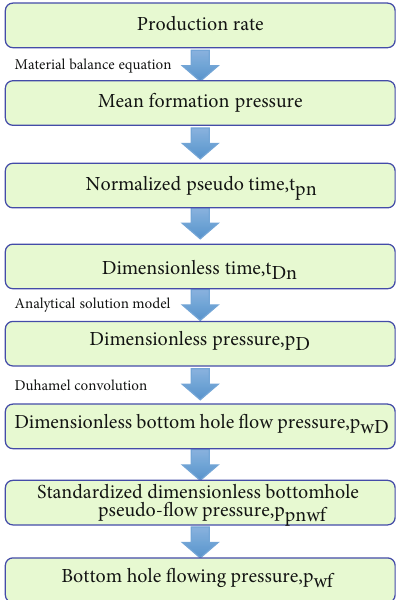
Figure 7: The Duhamel convolution is used to obtain pressure.